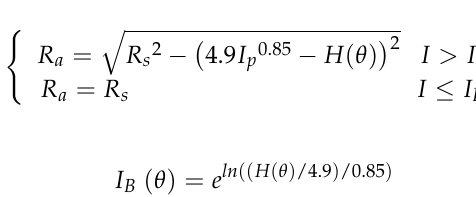
Figure 6. The structural model of a wind turbine. Substituting (5) in (8) yields: